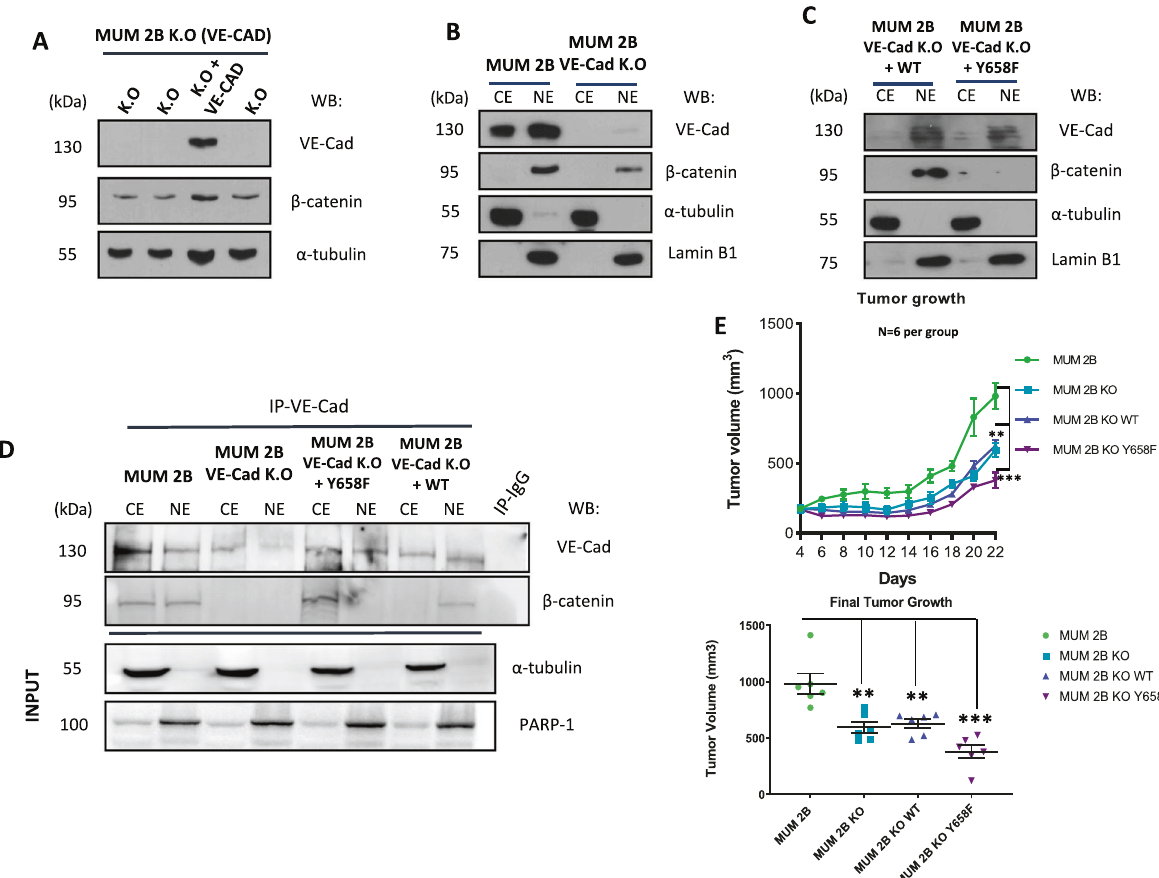
that VE-cadherin/Y658 is essential for β -catenin stabilization. D Immunoprecipitation after cytosol-nucleus fractionation of VE-Cadherin in MUM 2B cells, VE-Cad K.O, VE-Cad K.O WT VE-Cad, VE-Cad K.O Y658F construct (1 µgr during 48 h), input was used to protein